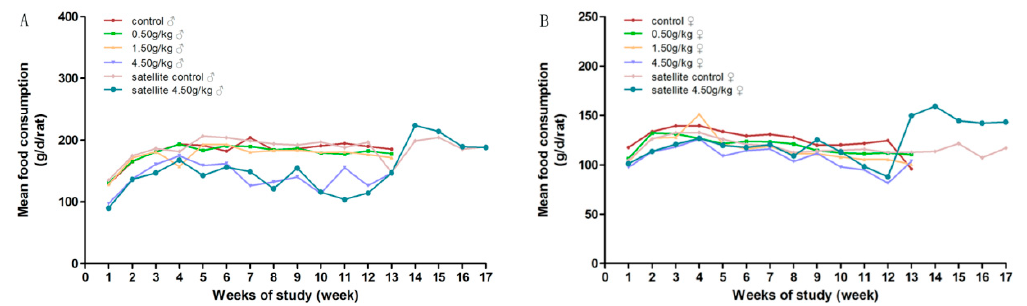
Figure 3. Average daily food consumption of rats orally administrated with gardenia yellow for 90 days. ( A ) female; ( B ) male.